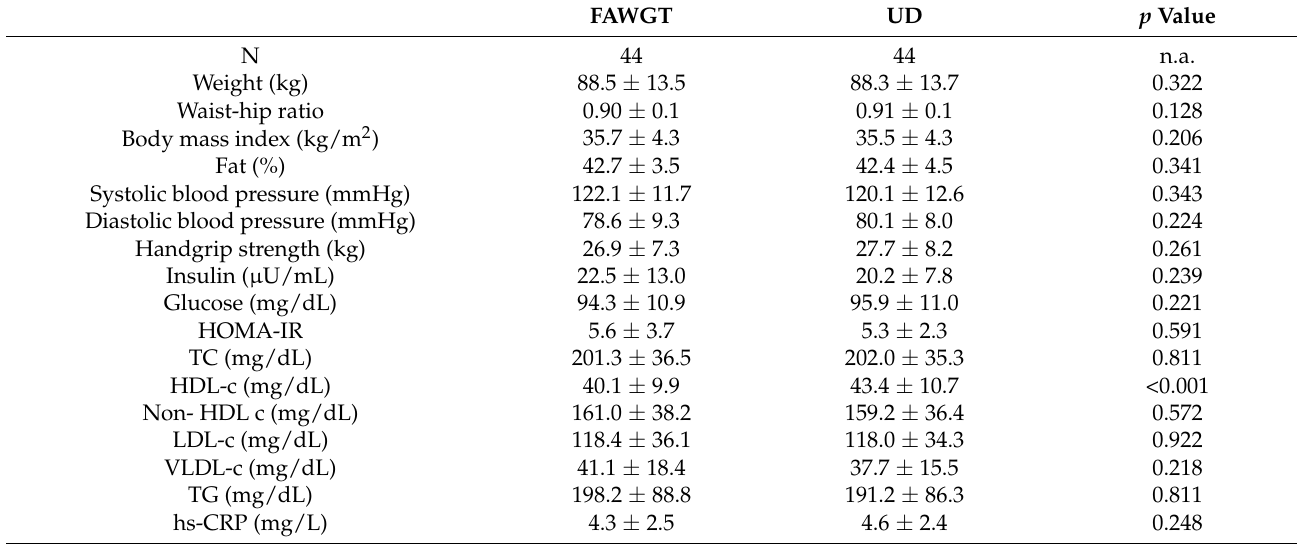
Table 2. Characteristics of the participants before starting each dietary intervention after the wash-out